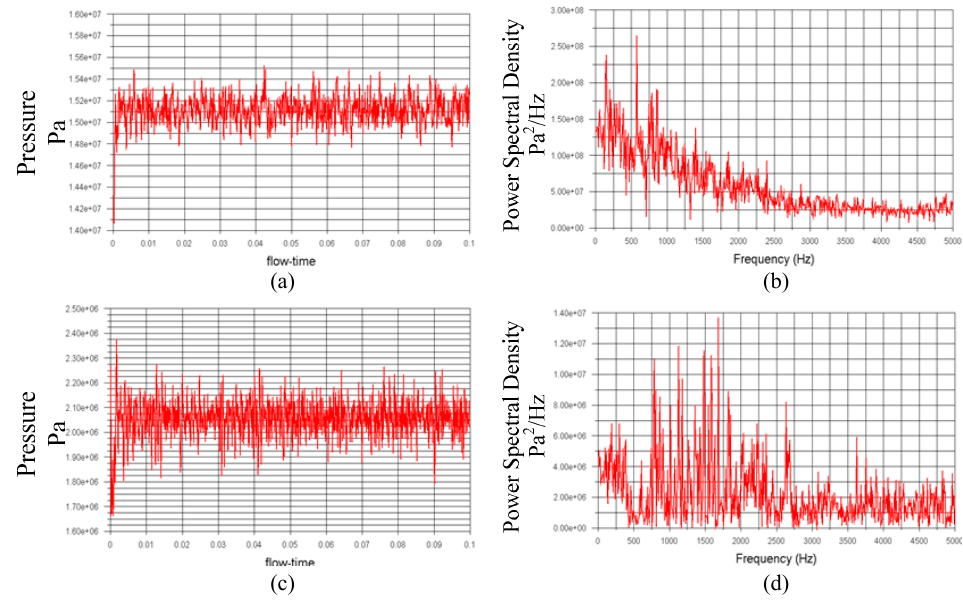
Figure 26. Pressure oscillation curve of the flapper under the influence of the main valve when the displacement of the flapper is x = 0.10 mm. ( a ) Point 1 in the time domain. ( b ) Point 1 in the frequency domain. ( c ) Point 2 in the time domain. ( d ) Point 2 in the frequency domain.